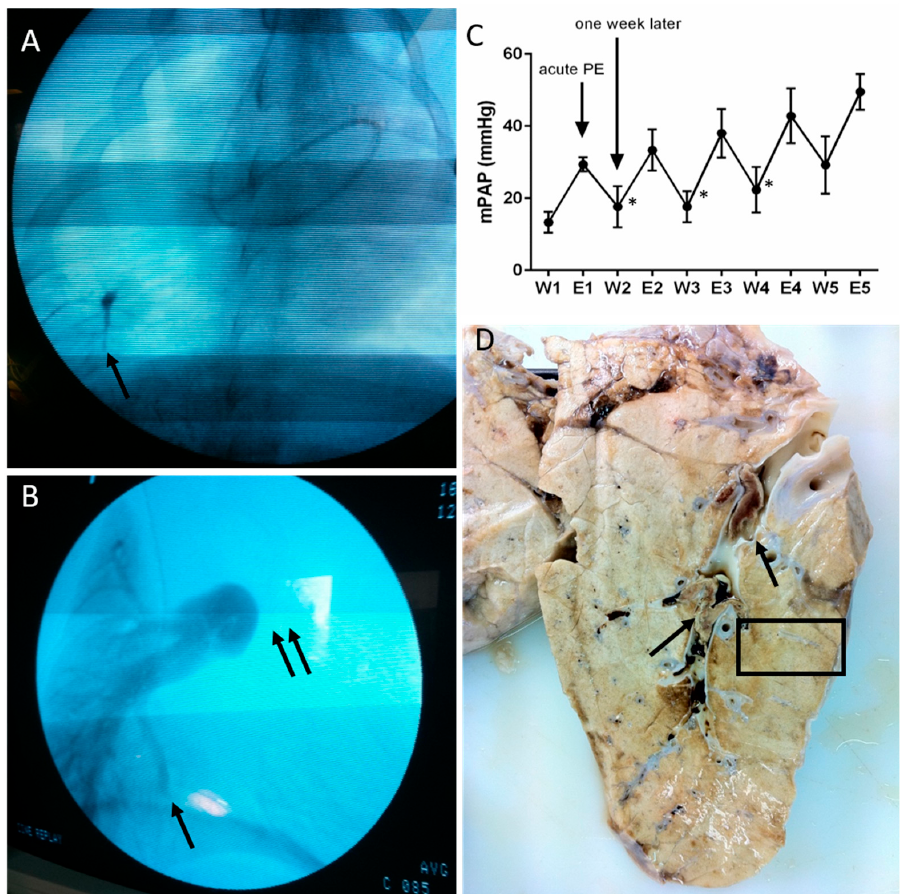
Figure 1. Imaging, hemodynamics and gross anatomy associated with iterative embolism of the right lower lobe in our large animal model of chronic thromboembolic pulmonary hypertension. ( A ) Thoracic fluoroscopy after an acute pulmonary embolism of the right lower lobe. The arrows show the embolic specimen of right lower lobe pulmonary arteries with enbucrilate mixed with lipiodol (contrast dye). ( B ) Pulmonary arteriography showing complete occlusion of the left pulmonary artery (double arrow) and distal pulmonary artery occlusion in the right lower lobe (simple arrow). ( C ) Iterative measurements of mean pulmonary artery pressure (mean ± standard deviation) before (Wn) acute pulmonary embolism and immediately after (En), n being the week of acute pulmonary embolism. * p < 0.05 compared to the previous value. ( D ) Gross anatomy of right lower lobe; the arrows show chronic proximal pulmonary artery occlusions; the block rectangle shows the limits of the pathological specimens used for histopathological